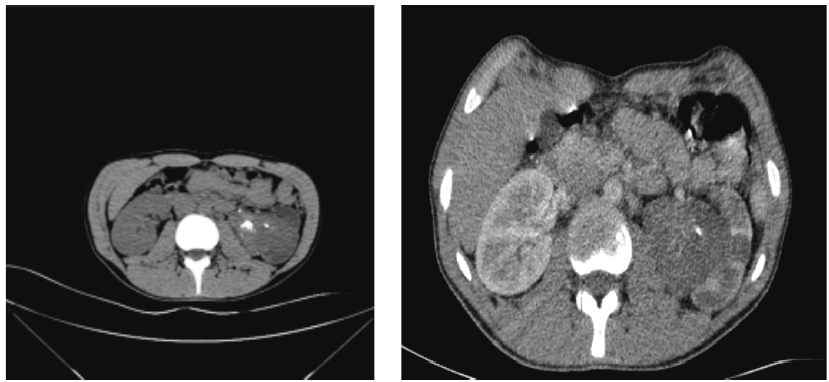
Figure 2: Preoperative CT with and without